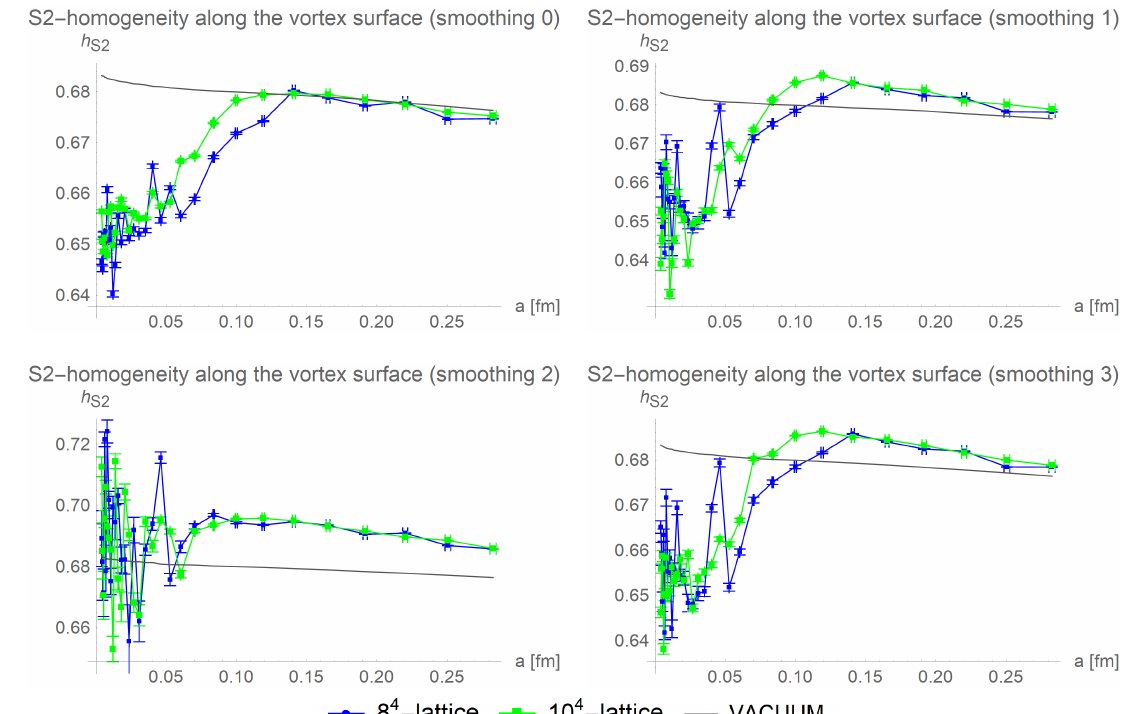
Figure 14. Averaged over 100 configurations, the S2-homogeneity along the vortex surface is compared for different lattice sizes and smoothing procedures after three cooling steps. The vortex is no longer distinguishable from the vacuum for smoothing 0, and all other smoothing procedures homogenize the vortex compared to the vacuum.